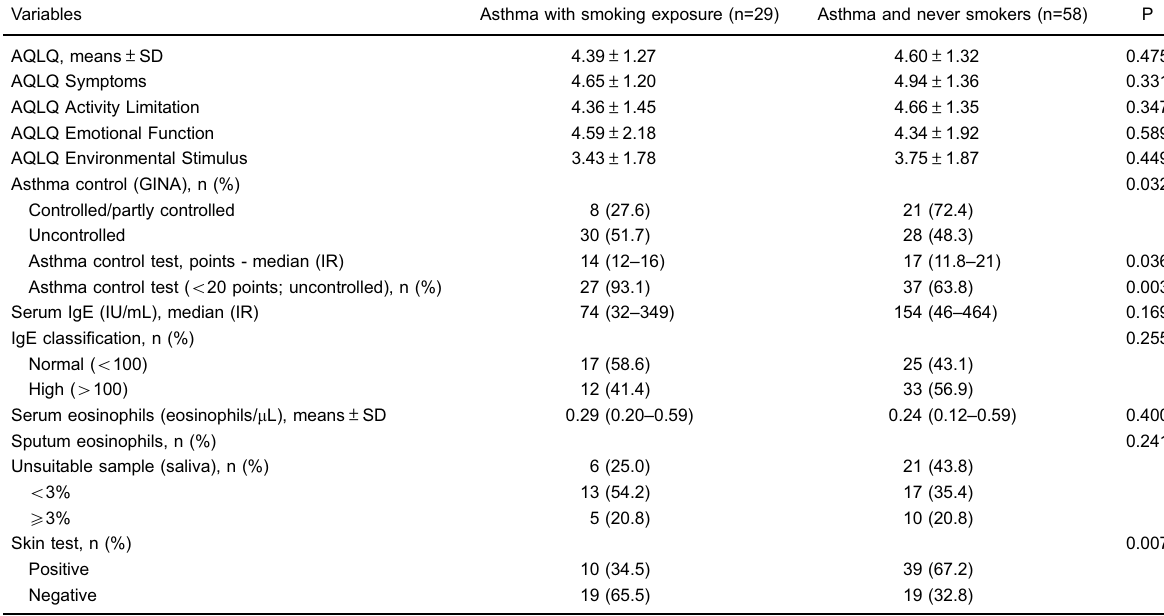
Table 2. Comparison of quality of life, asthma control, IgE, eosinophils, and skin test between groups. Variables